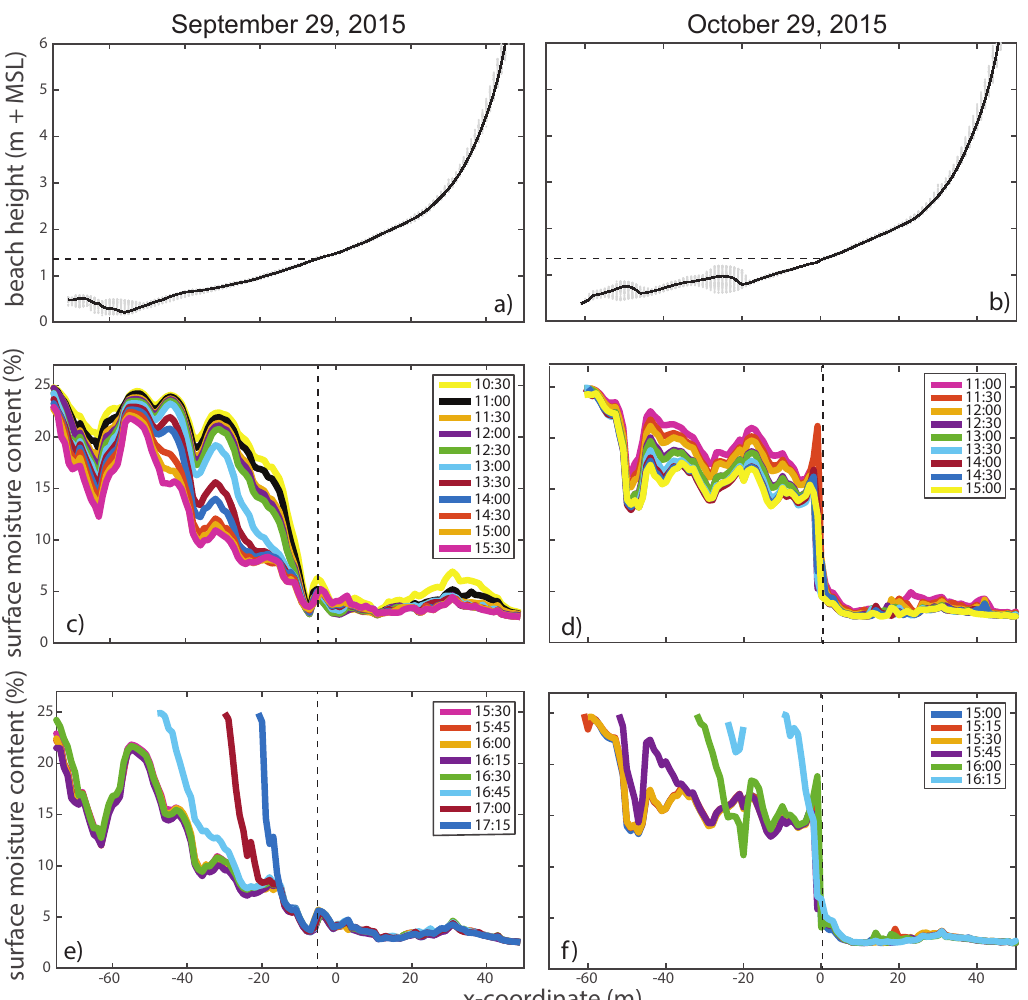
Figure 7. Surface moisture dynamics and beach morphology during falling and rising tide on 29 September and 29 October 2015. ( a , b ) show the median of all beach height ( z ) values of the same x -coordinate for 29 September and 29 October, respectively, in a side view from the sea (left) towards the dunes (right); ( c , d ) show the median of all surface moisture measurements along the same x -coordinate for the indicated time step when a TLS survey was conducted (per half an hour) during falling tide; ( e , f ) show the same information as the ( c , d ) only during rising tide and the time interval between the TLS surveys is set to 15 min. Note the high water line on 29 September lies around x ∼ − 5 m and for 29 October around x ∼ 0 m. Figure 8a,b shows a summary of all median surface moisture transects for each laser scanning day (29 September and 29 October, 2015, respectively). Figure 8 reveals that, consistent with earlier studies [15,19], the beach can be conceptualized into three surface moisture zones: (1) the wet zone, the beach just above the low-tide swash with w s ∼ 18–25%; (2) the intertidal zone with w s ∼ 5–25% (with large spatiotemporal fluctuations indicated by the 2.5 and 97.5 percentile lines); and (3) the back beach zone: w s ∼ 3–7%. The bar–trough system is visible as a disturbance to this overall zonation. The trough remains always saturated, while the more seaward bar can dry to between